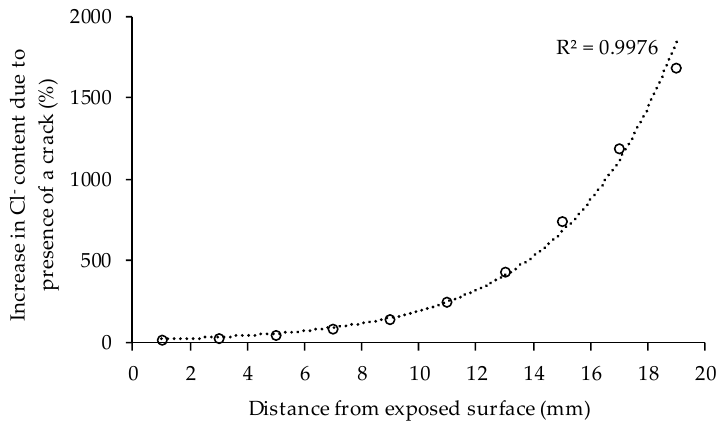
Figure 5. Increase of chloride concentration in function of the distance from the exposed surface due to the presence of a crack (exposure period of 49 days). The dotted line represents an exponential fit. The corresponding coefficient of determination ( R ²) is denoted in the graph.